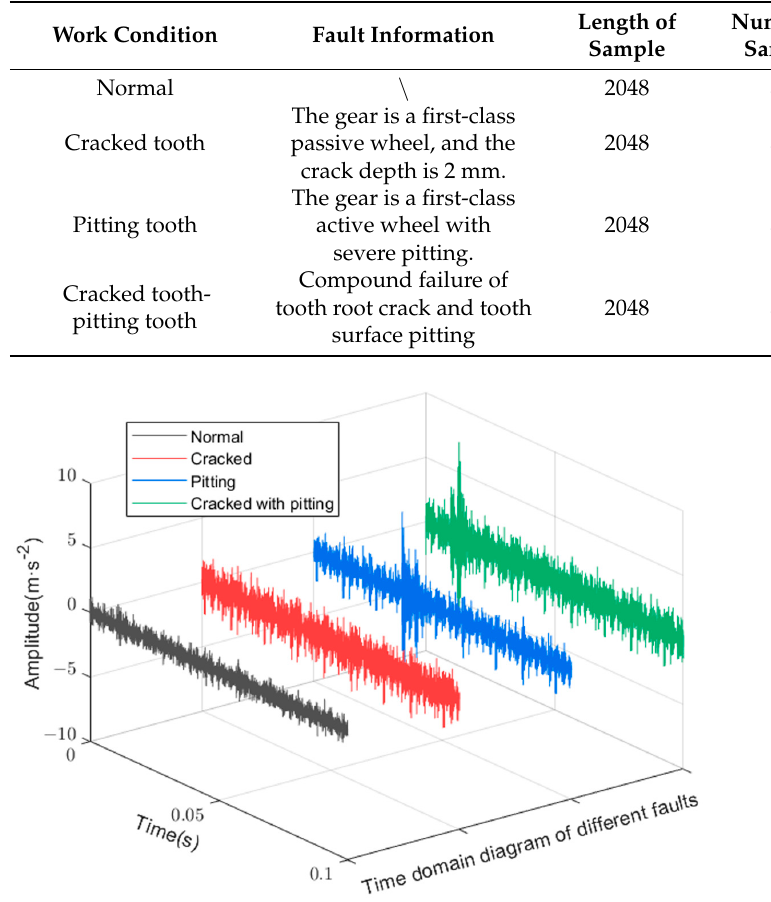
( b ) Figure 13. Simulation experimental training process of CSAM-MSCNN: ( a ) Loss function curve; ( b ) accuracy curve.